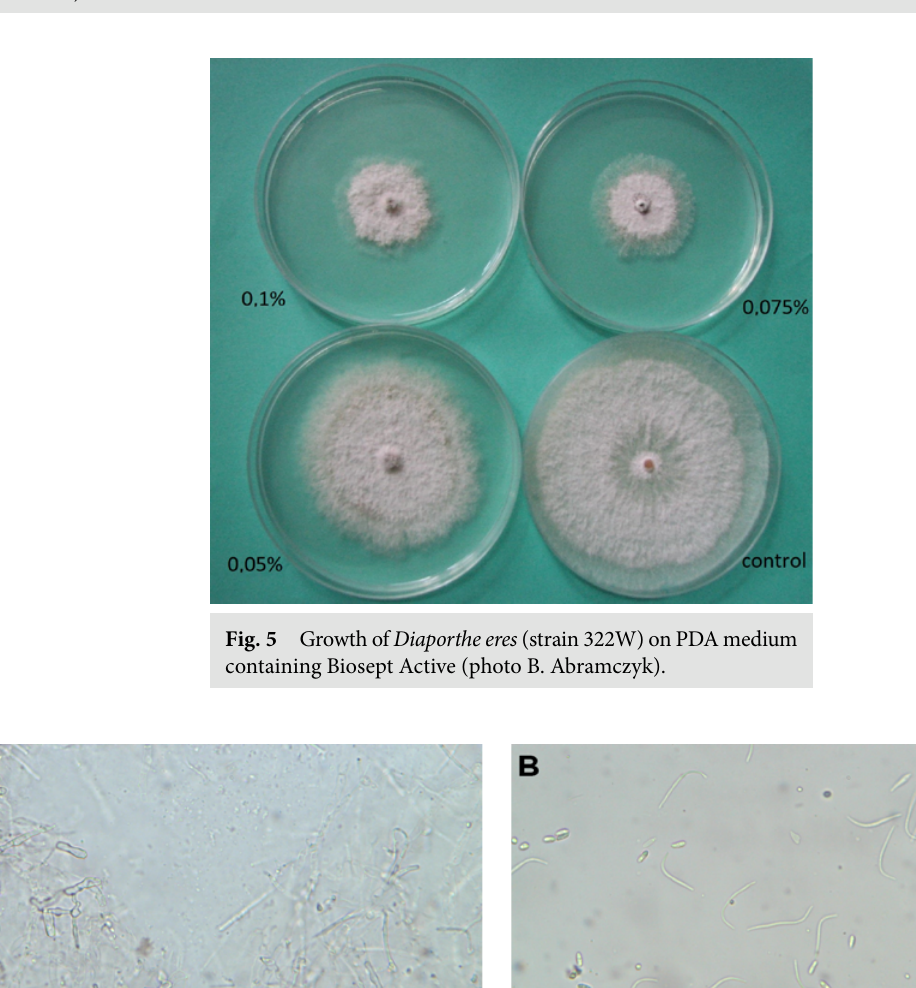
Fig. 4 Predominance of alpha-type conidia in the control ( A ) and beta-type conidia in cultures growing in the presence of fungicides ( B ) (photo E. Król).